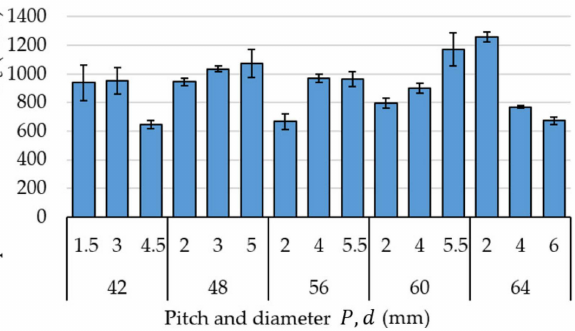
Figure 4. Defined values of compression modulus E c divided into specific diameters and thread